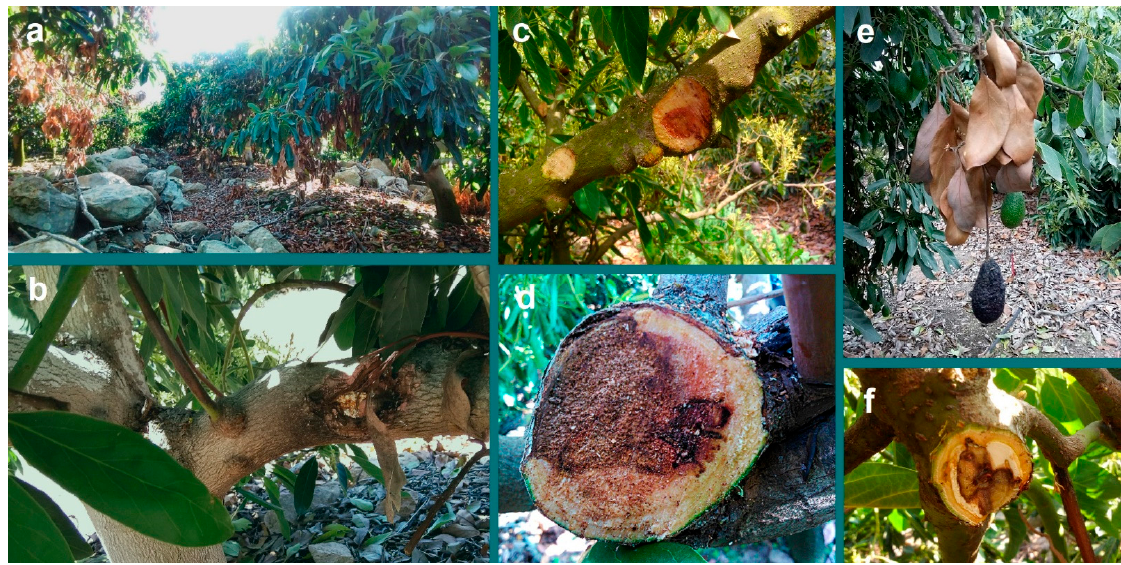
Figure 1. Symptoms of branch canker and dieback. ( a ) Chilean orchard with high levels of branch canker and dieback incidence. ( b ) Cankers and friable bark on a main branch near the trunk. ( c ) Branch with protuberances and internal necrotic tissue. ( d ) Internal necrosis in the inner tissue of a trunk associated with canker. ( e ) Branch with dieback with wilted leaves and small black dried fruits. ( f ) Inner tissue damage due to dieback. Table 1. A summary description of the health conditions, agroclimatic zones, and geographic loca- tions of the 16 studied orchards based on the classification of Pérez and Adonis (2012).